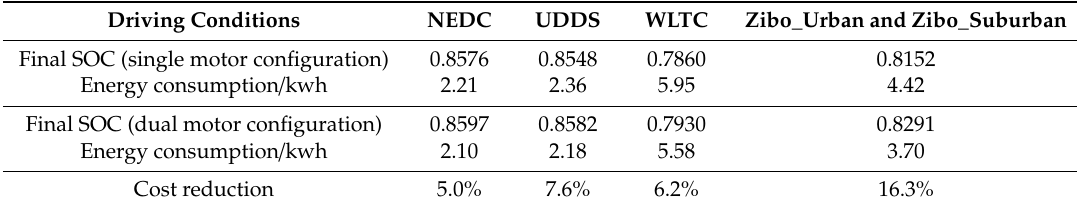
Table 7. Energy saving e ff ect under other driving